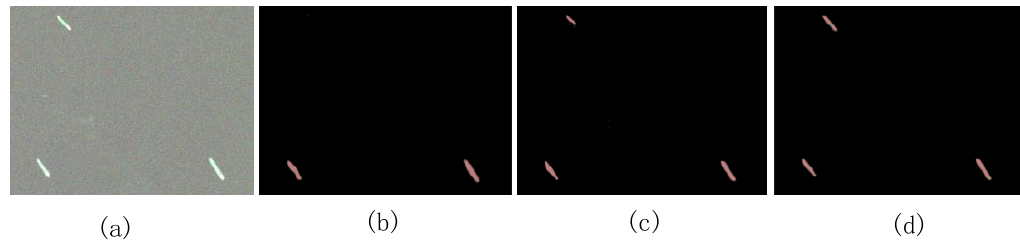
Figure 4. Semantic segmentation of ships under a calm sea surface. ( a ) Original ( b ) Conditional random field as recurrent neural network (CRF-RNN) ( c ) DeepLab ( d ) Proposed model.